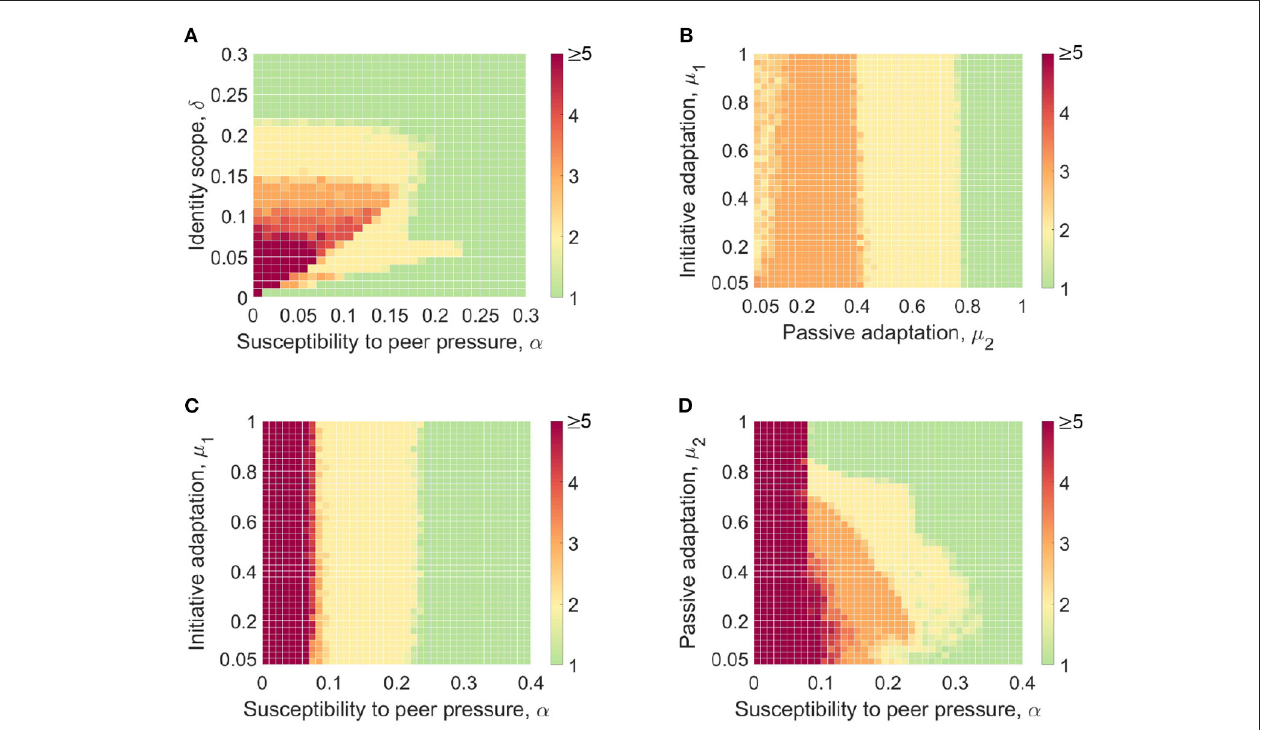
FIGURE 6 | Simulation results on homogeneous populations. The number of opinion clusters is shown under different combinations of (A) identity scope ( δ ) and susceptibility to peer pressure ( α ), (B) initiative adaptation speed ( µ 1 ) and passive adaptation speed ( µ 2 ), (C) µ 1 and α , as well as (D) µ 2 and α , respectively. Results highlight that the number of opinion clusters first increases and then decreases as identity scope or passive adaptation speed grows. All simulation results are averaged over five times. Parameters: (A) µ 1 = 0.7, µ 2 = 0.7, (B) δ = 0.05, α = 0.18, (C) µ 2 = 0.7, δ = 0.05, (D) µ 1 = 0.7, δ =